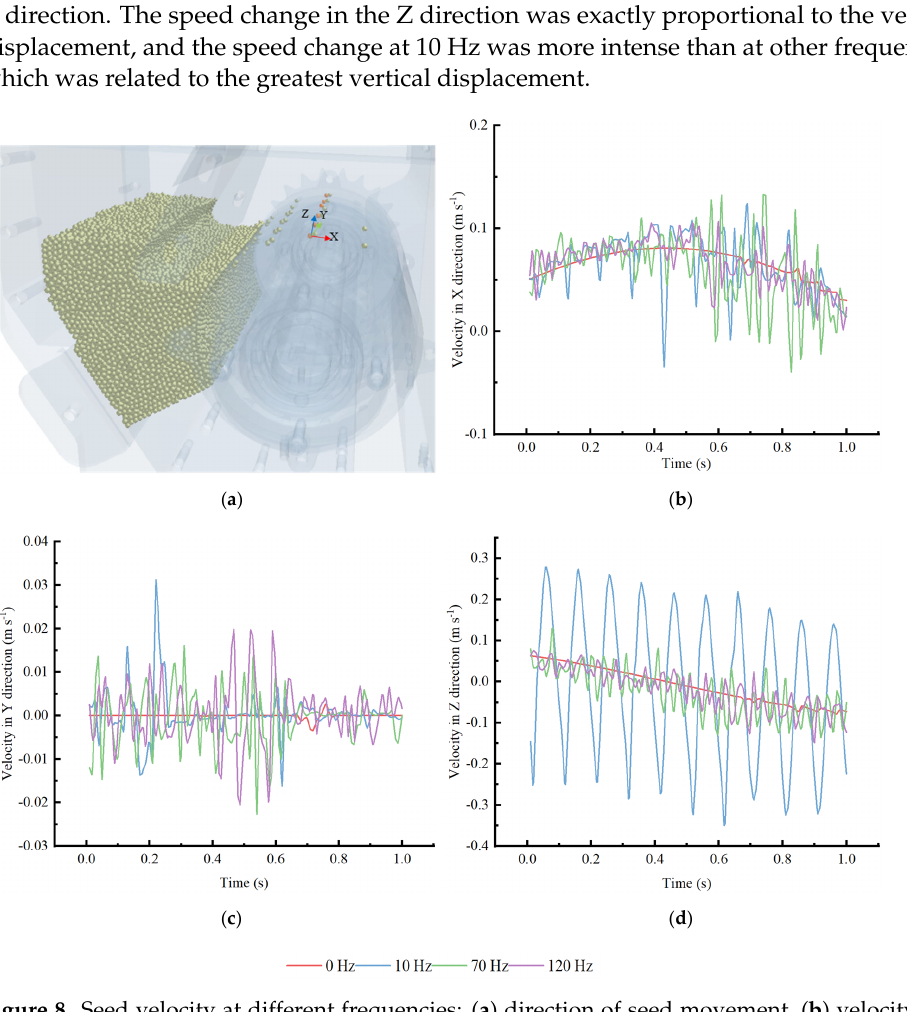
Figure 8. Seed velocity at different frequencies: ( a ) direction of seed movement, ( b ) velocity in X direction, ( c ) velocity in Y direction, and ( d ) velocity in Z direction. The Y direction is the axis direction of the seed − metering wheel, and the Z direction is the opposite direction of gravity.